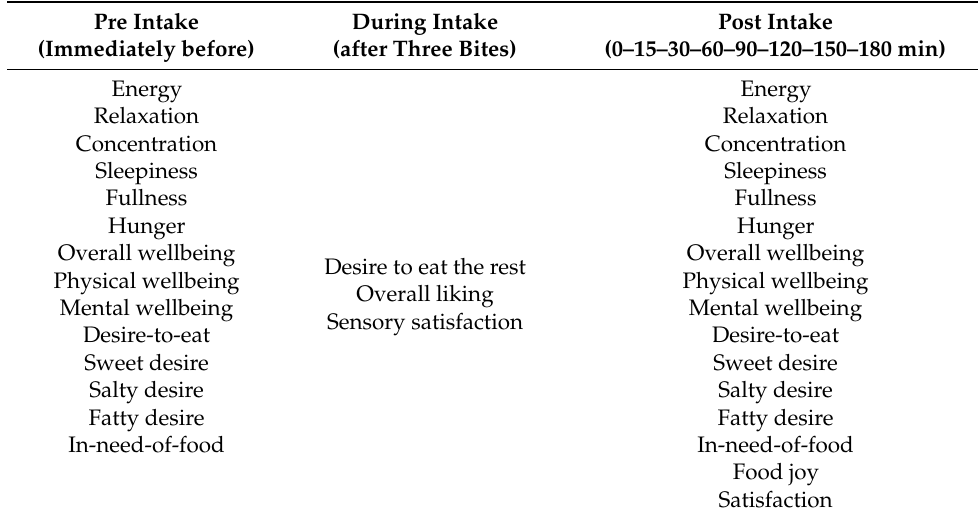
Table 3. Response variables included in the questionnaire pre-, during-, and post